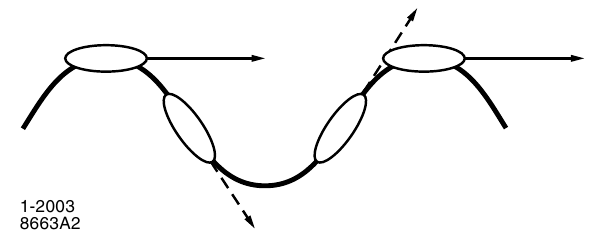
FIG. 8. Physics model to explain the peaks and zeros of G (cid:5) s (cid:6) shown in Fig. 1. The solid line stands for the electron trajectory. The ellipses stand for the electrons. The arrows stand for the instantaneous direction of the motion. We group the four electrons into two pairs, one with solid arrows and the other with dashed arrows. Again, the trailing electron in each pair satisfying the retarded condition is shown at the retarded time, and the front electron at the test